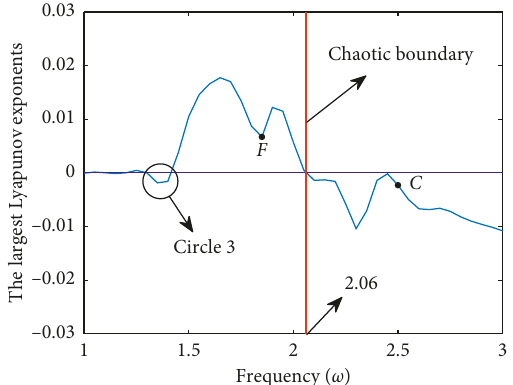
Figure 7: The largest Lyapunov exponents ( F �